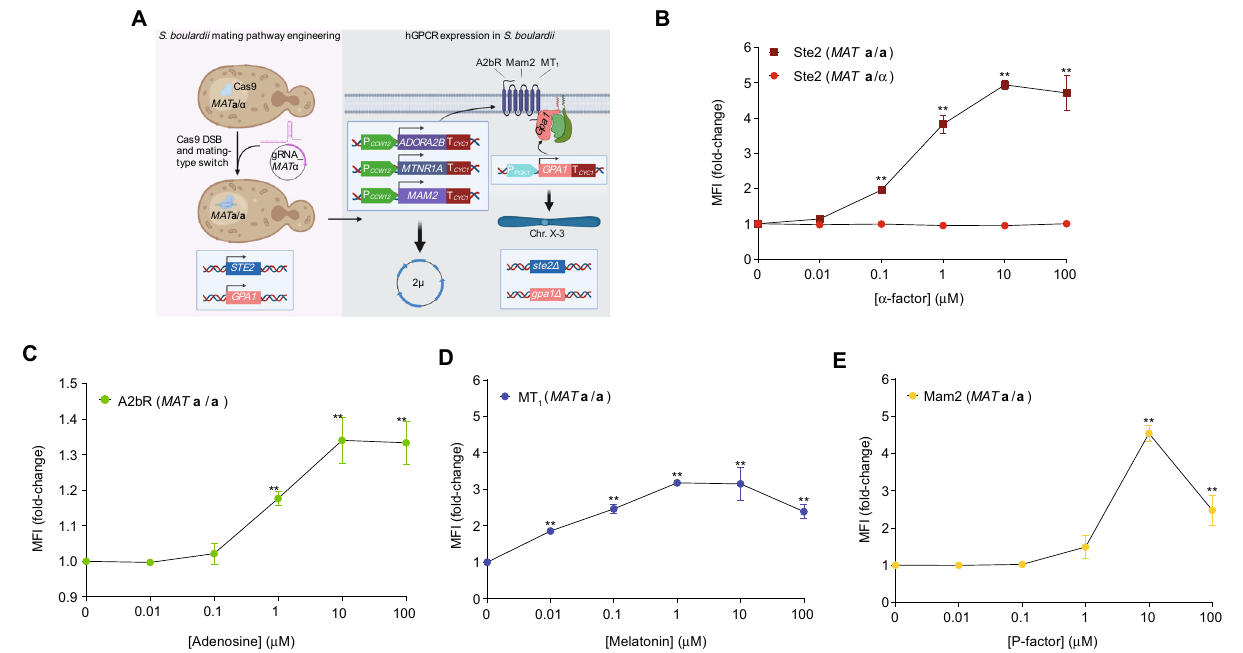
Fig. 2 | One single genetic edit enables GPCR-signaling in probiotic yeast. A Homozygousmating-typeswitchin MAT a / α diploidcellswithCRISPR/Cas9(left). Cas9 is pre-expressed in S. boulardii prior to transformation with a single gRNA plasmid that targets MAT α in the genome for double-strand break (DSB). The endogenous MAT a copy templates Cas9-induced double-strand break repair (not shown) and converts the cell into a MAT a / a diploid. G α expression is engineered from the PGK1 promoter, and heterologous GPCRs (hGPCRs) are expressed from 2 µ plasmids (right). B – E Median fl uorescence intensities (MFI) of P FUS1 - GFP reporter expression from plasmid pDAM194 following incubation with cognate